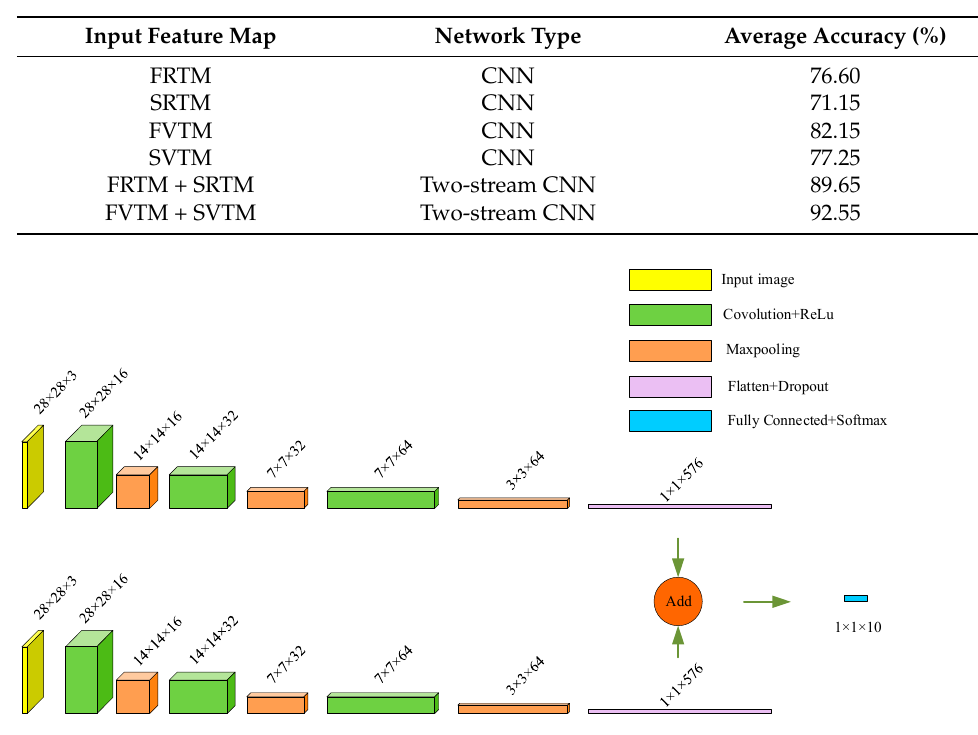
Table 3. Tests on different input feature maps.